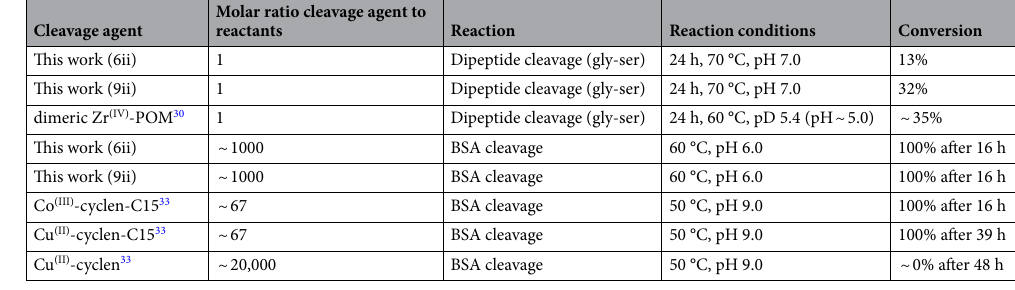
Table 1. Overview over the obtained conversions for peptide bond fission reactions and comparison to best- performing systems in